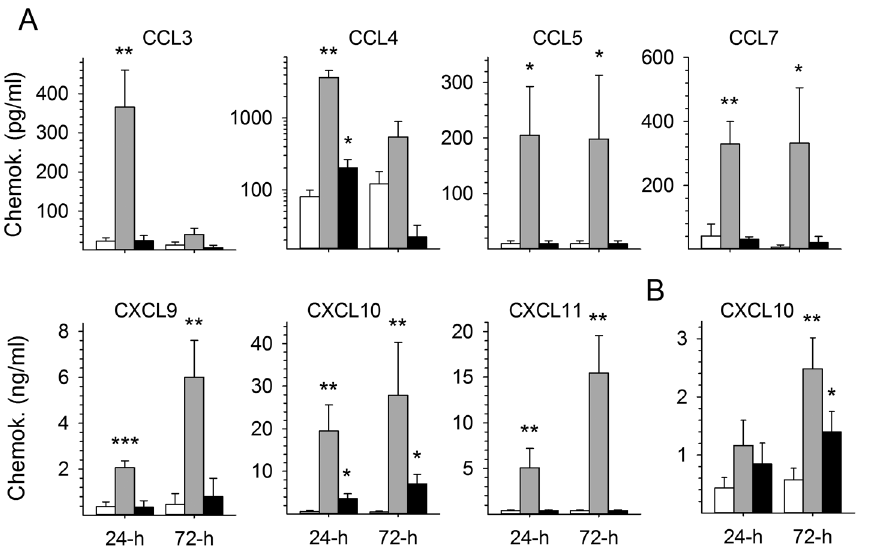
Figure 2. Release of chemokines into the supernatants of DC and MP infected with LASV and MOPV. The levels of CC and CXC chemokines were quantified by ELISA in the supernatants of MP (A) and DC (B) 24 and 72 h after mock (white bars), MOPV (gray bars), and LASV (black bars) infection. Results are expressed in pg/ml and ng/ml for CC and CXC chemokines, respectively. Significant differences are indicated as follows: * ( p , 0.05), ** ( p , 0.01), and *** ( p ,